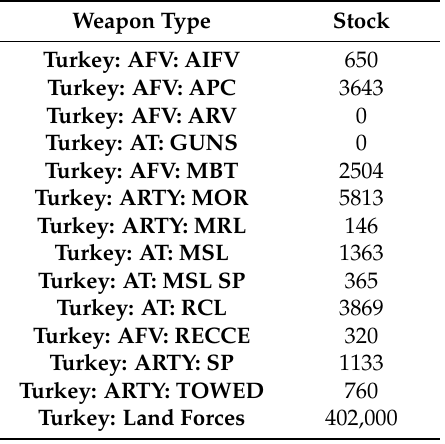
Table 2. Turkey’s capacity of weapon types. For more information on data sources, please refer to Section 4.1 (Data